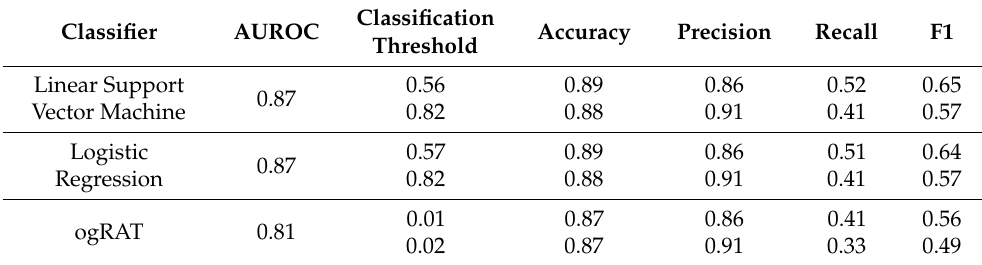
Table 3. Performance of machine-learning-based probabilistic classifiers on test dataset (results shown for some of the best-performing techniques: Support Vector Machine with linear kernel and Logistic Regression with stochastic average gradient solver) in comparison with oesophago-gastric cancer risk-assessment tool (ogRAT) matrix (performance calculated on same test set) for prediction of oesophago-gastric cancer incidence. Performances shown when making comparisons using the exact precision values achieved by the